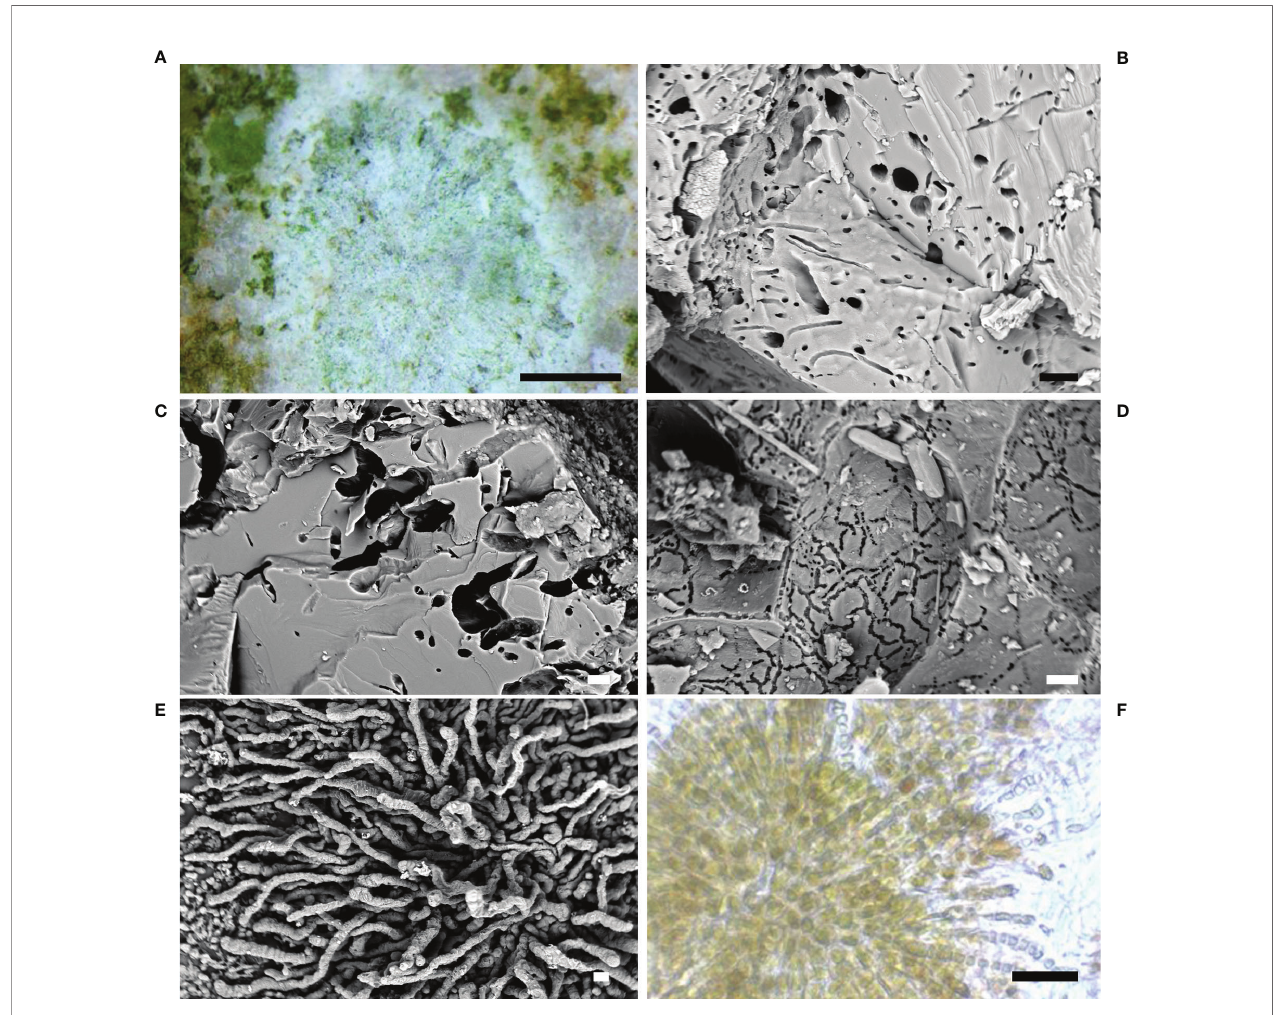
FIGURE 2 | Cyanobacteria. (A) Cyanobacteria colonization on calcareous substrate (stereomicroscope image); (B – D) microboring caused by endolithic cyanobacteria in the stone (SEM image); (E) the ichnospecies Fascichnus dactylus (SEM image); (F) the radiated bundles of the species Hyella caespitosa (optical microscope image). Scale bars: (A) = 0.5 mm; (B – D) = 10 µm; (E, F) = 20